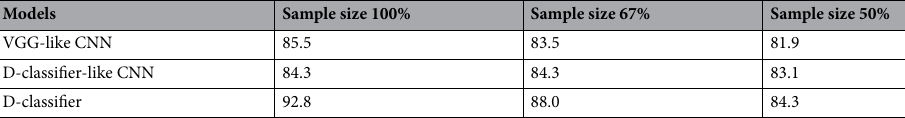
Table 7. Classification performance of three models’ comparison with varying sample size for AD versus CN.